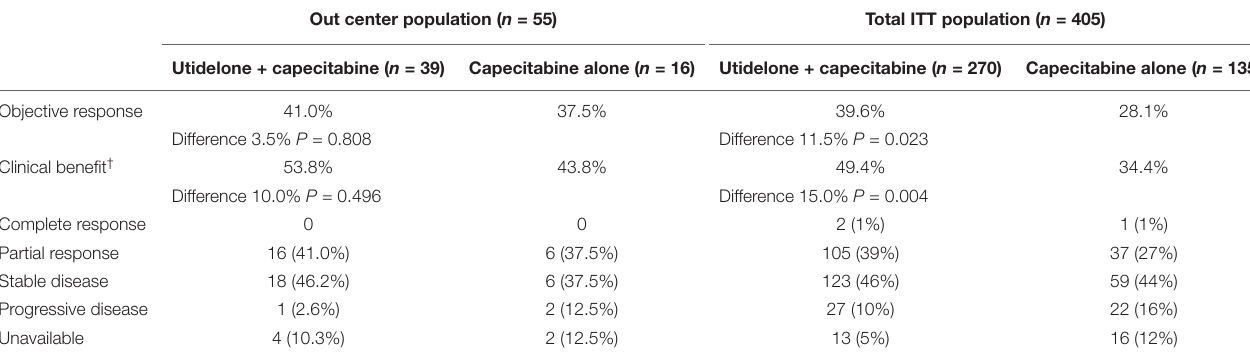
TABLE 2 | Objective response and clinical benefit rates in our center and ITT population.